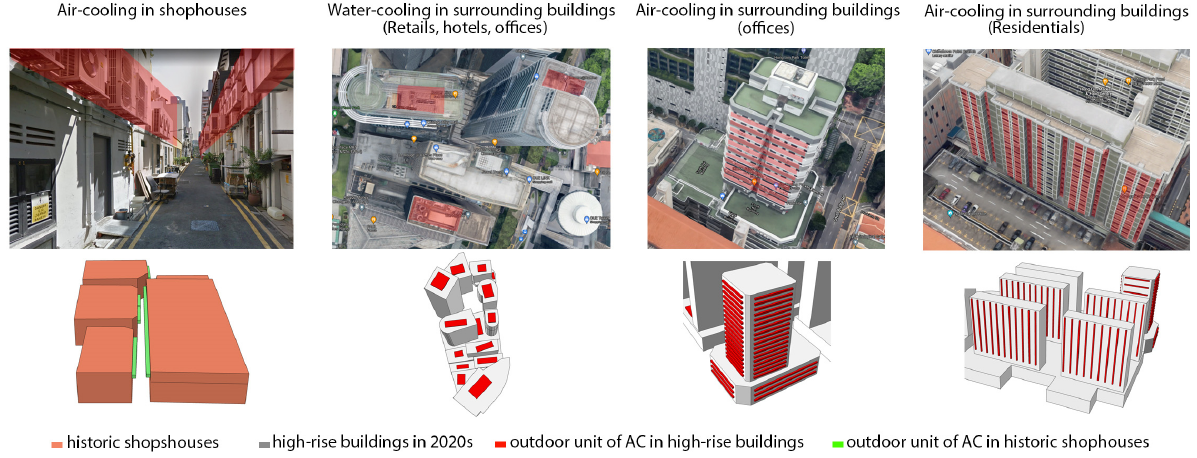
Figure 6. Examples of locations and geometries of heat sources regarding different AC types and building functions (AC—air conditioning).